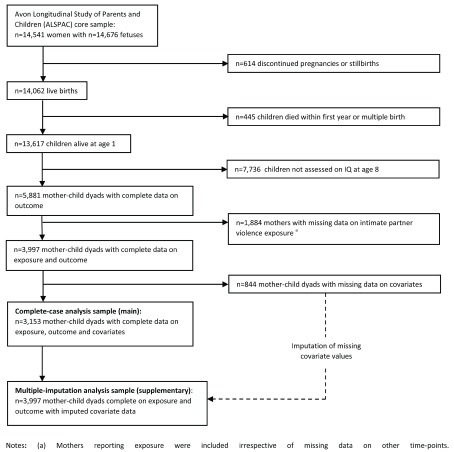
Selection of the study population.